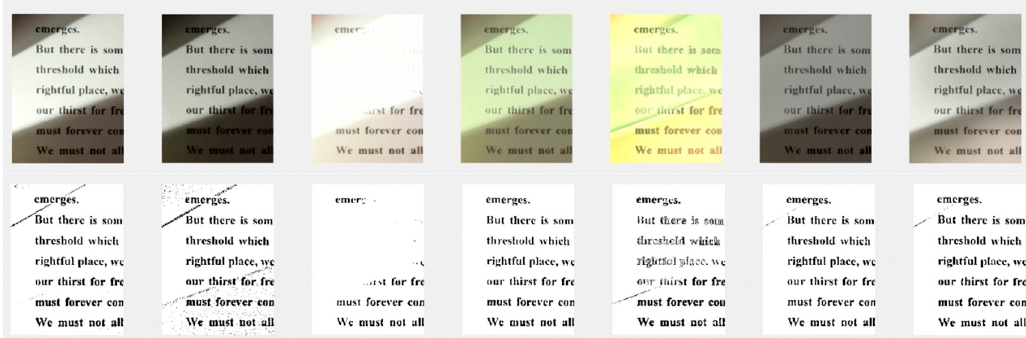
Figure 14. One over-exposed region in well-exposed images. From left to right: well-exposed image, under-exposed image, over-exposed image, ReinhardTMO HDR image, DurandTMO HDR image, Goshtashy fusion, and the Merten fusion method. The images in the top row correspond to RGB images and the images in the bottom row correspond to binary images.